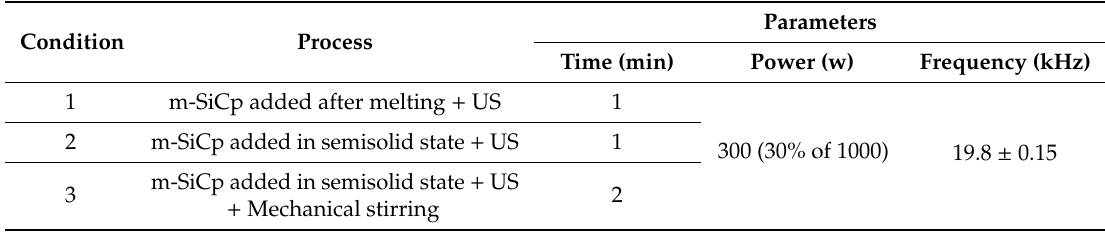
Table 2. Testing conditions.